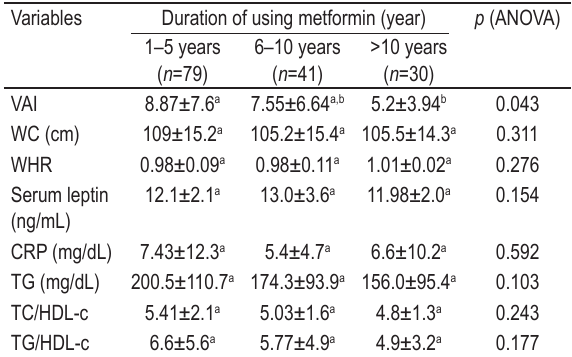
TABLE 4. Effects of metformin use duration on the anthropometric markers, serum leptin, and C‑reactive protein levels, and lipid profile markers of Iraqi patients with type 2 diabetes mellitus ( n =150) Variables